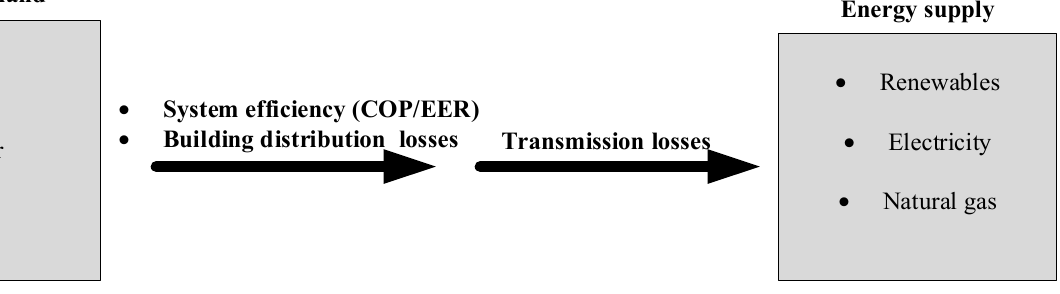
Figure 10. Energy demand to energy supply in buildings [31].